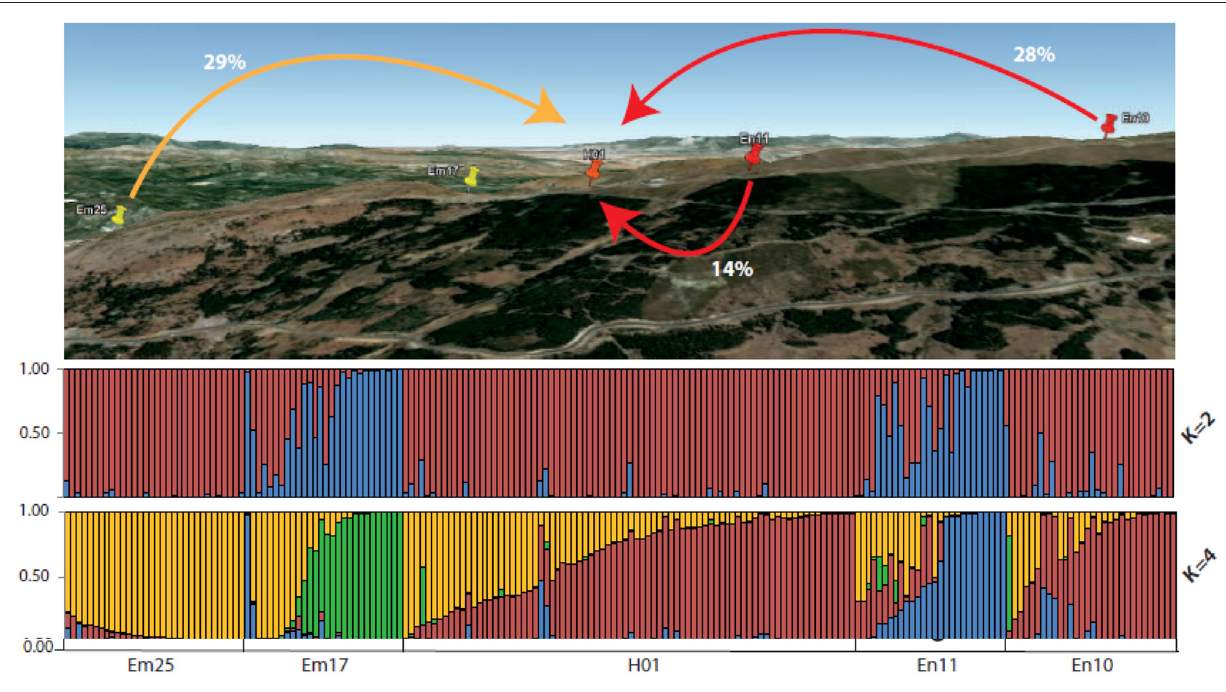
FIGURE 3 | Significant gene flow values among E. mediohispanicum and E. nevadense populations surrounding the hybrid zone. Bottom: diagram with individual barplots from STRUCTURE (K = 2 and K = 4) based on the variation of 10 unlinked microsatellite